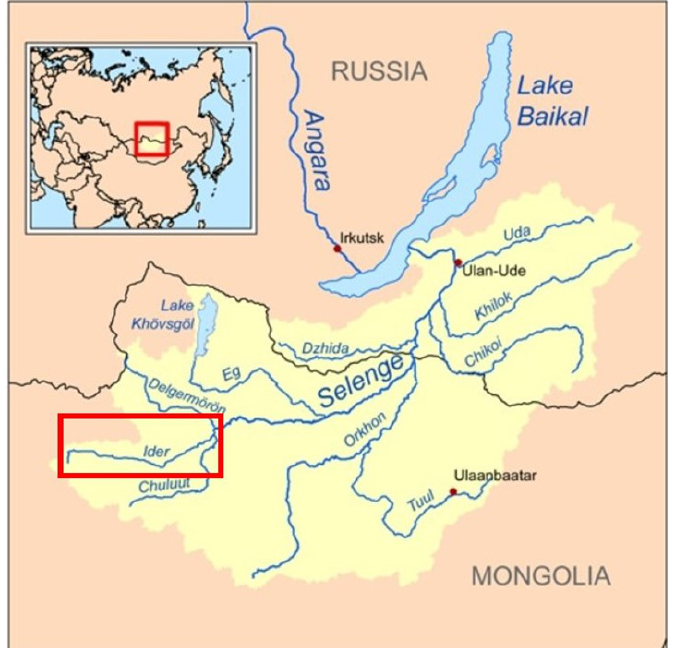
Figure 1 . Geographical location of Ider